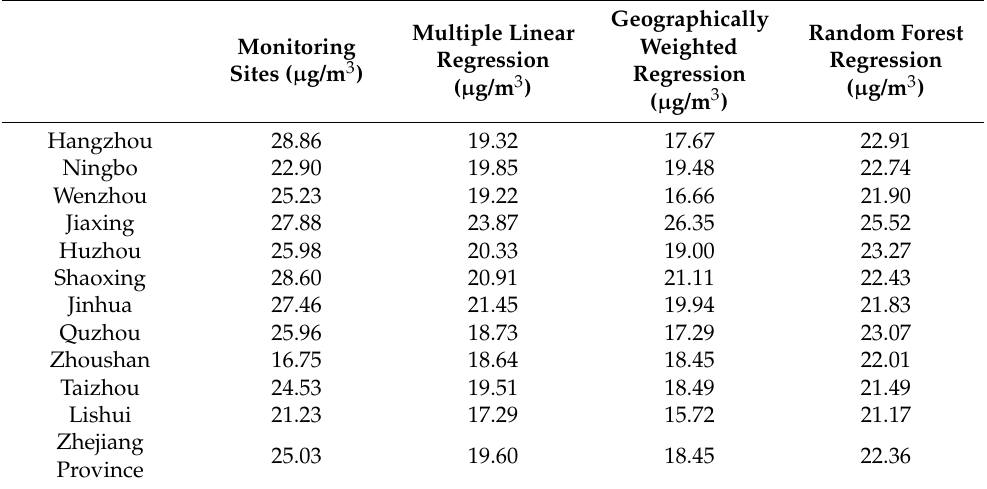
Table 4. Each city’s average PM 2.5 concentrations based on monitoring stations and regression model